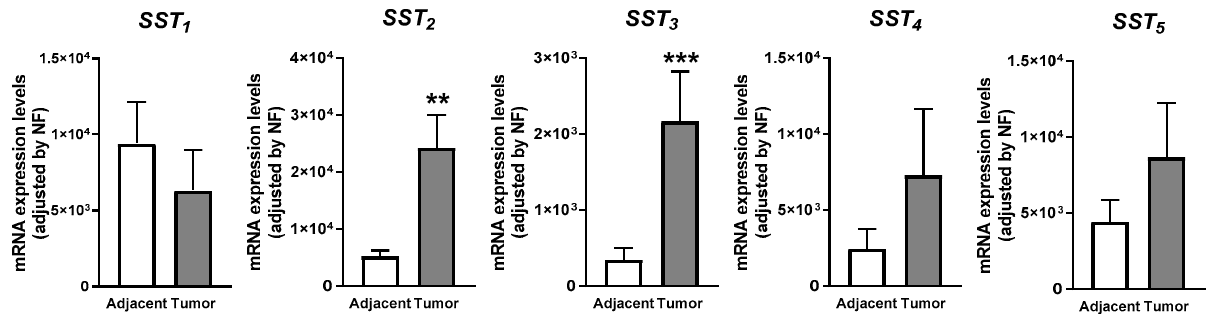
Figure 1. mRNA expression levels of Somatostatin Receptors. mRNA expression levels of SSTs genes were measured by qPCR and adjusted by normalization factor. Values represent the mean ± SEM. Asterisk represents statistically significant differences (**, p < 0.01; ***, p <